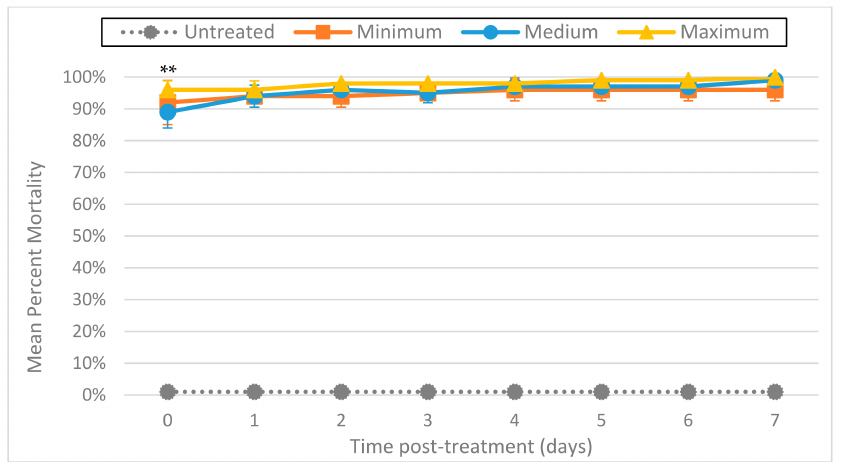
Figure 7. Mean percentage mortality from sonicating A. cantonensis larvae at 40 kHz with the Branson 1510 ultrasonic cleaner for 1 min while simultaneously exposing them to ozone for 5 min from the Enaly OZX-300 at 3 different outputs (minimum, medium, and maximum). All tests were conducted in triplicate. Percentage mortality was normalized by adding the number of dissolved L3 to the number of fluorescent L3, then dividing by the original total number of L3. ** All 3 treatments were statistically significant as compared to untreated controls by day 0 ( p ≤